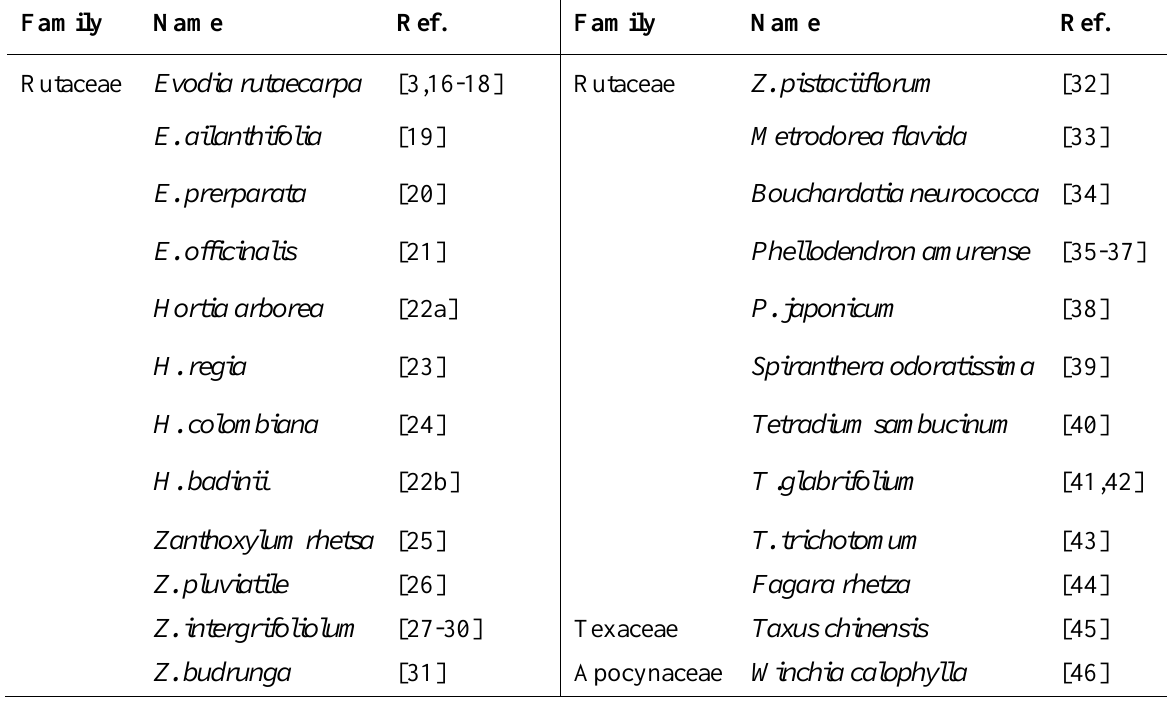
Table 3. Plant Sources of